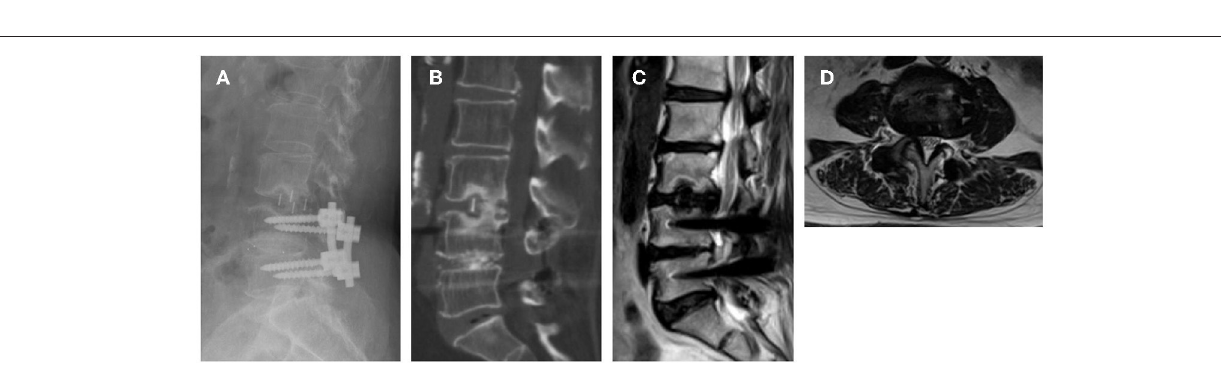
FIGURE 3 | Images obtained in a 66-year-old woman who had an L4–L5 posterior instrumented fusion 26 month ago. She experienced new leg pain and intermittent claudication due to adjacent-segment degeneration and stenosis for 2 months. (A) 18 months follow-up reviewed Grade I subsidence; (B) CT confirmed bony fusion was achieved; (C,D) Indirect decompression of spinal canal was